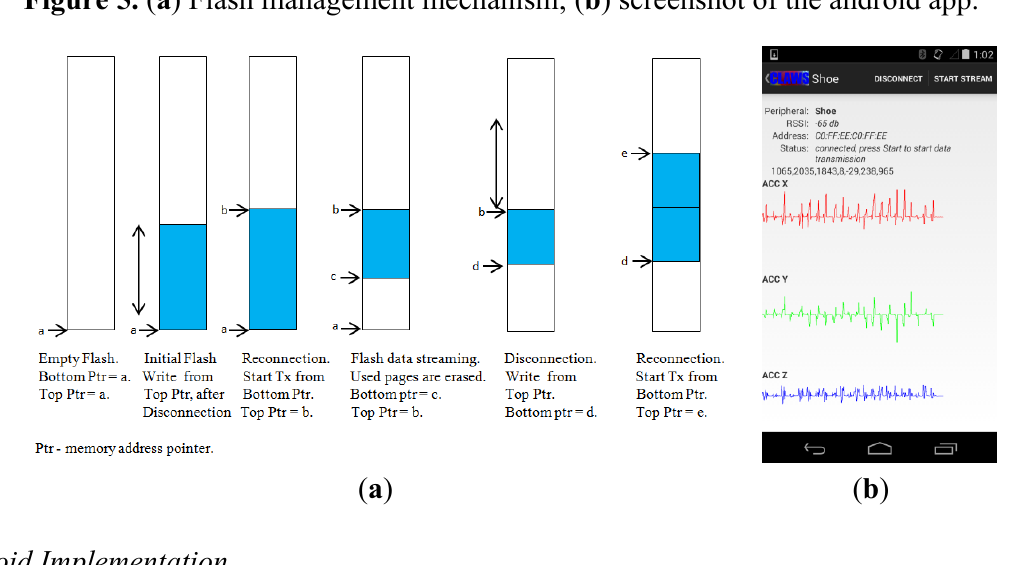
Figure 5. ( a ) Flash management mechanism; ( b ) screenshot of the android